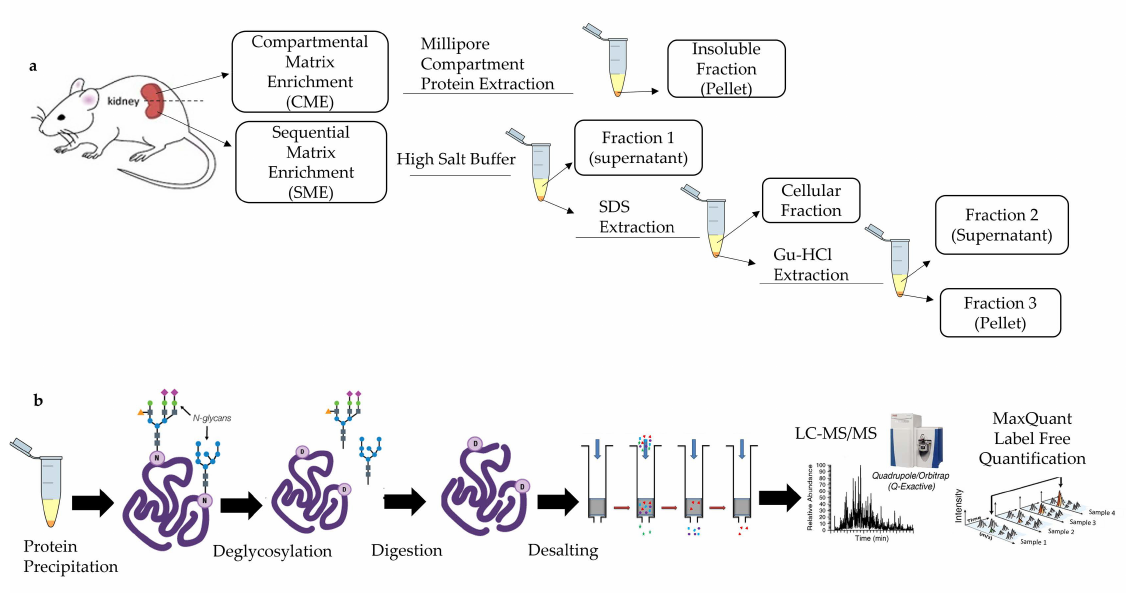
Figure 1. Schematic illustration of the methods applied in the current study. ( a ) Matrisome protein extraction from healthy mouse kidneys by CME and SME methods. ( b ) Further processing and analy- sis of proteins after obtaining samples from methods CME and SME. Yellow color in the extraction products indicates the supernatant, and the orange color shows insoluble pellets. Abbreviations: SDS (Sodium Dodecyl Sulfate) and Gu-HCl (Guanidine